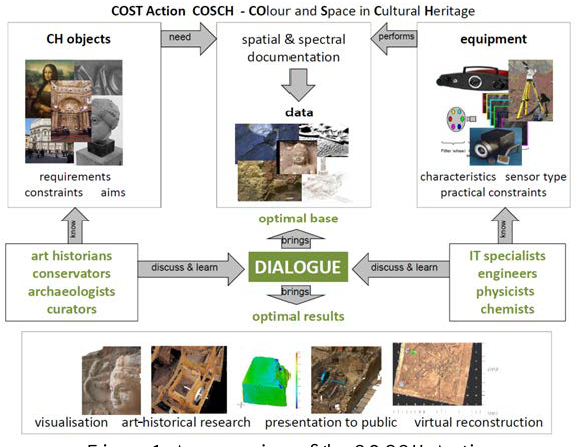
Figure 1. An overview of the COSCH